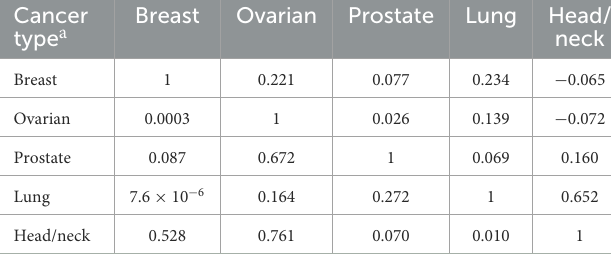
TABLE 1 Genome-wide genetic correlation between five solid cancers. Cancer Breast Ovarian Prostate Lung Head/ type a